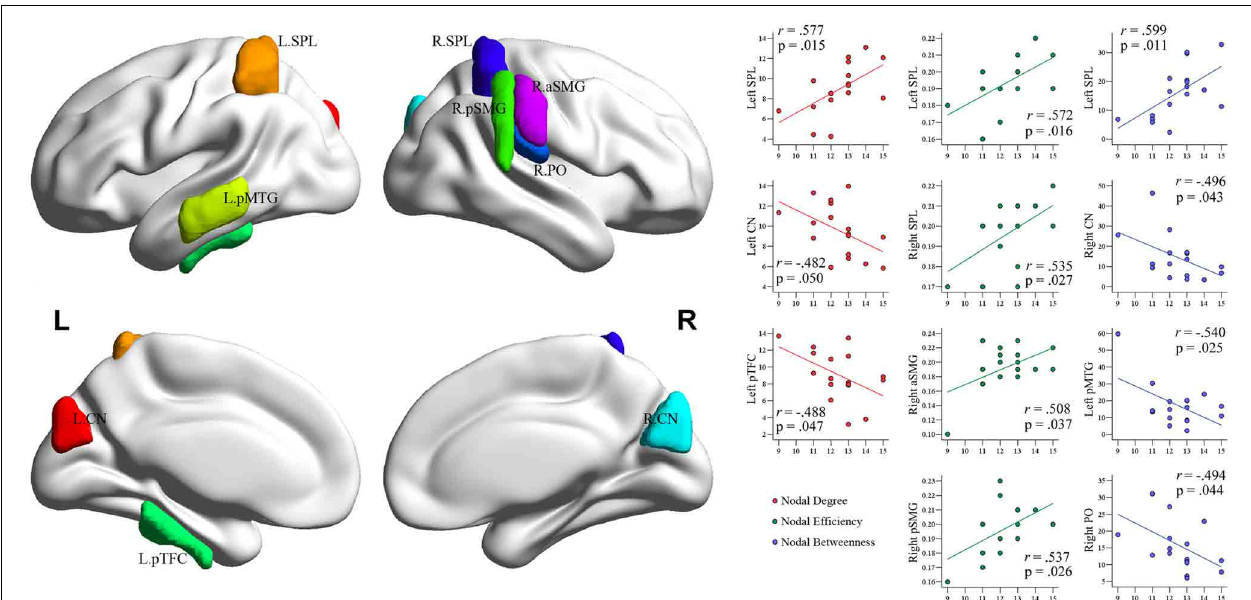
FIGURE 6 | Plots of the correlations between each nodal metric and training duration of experts. The value of regional nodal measures (red, nodal degree; green, nodal efficiency; blue, nodal betweenness)